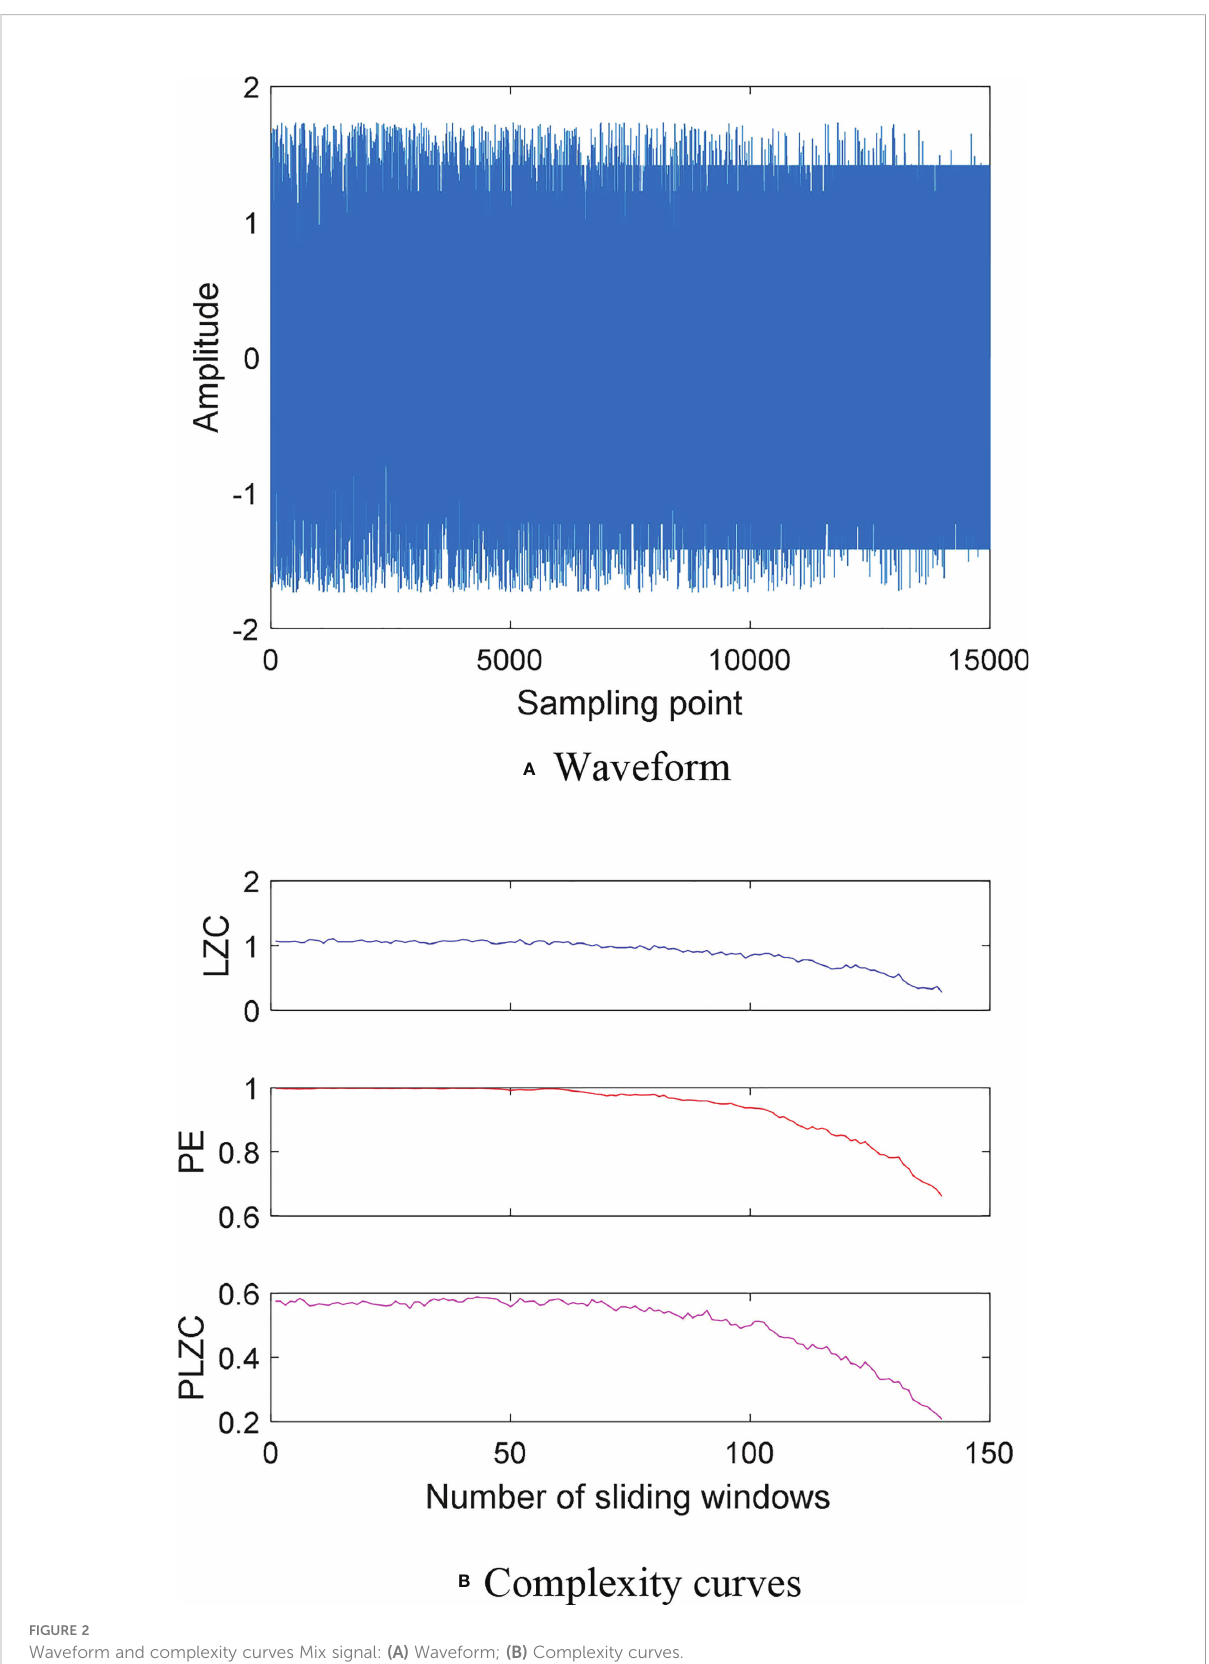
FIGURE 2 Waveform and complexity curves Mix signal: (A) Waveform; (B) Complexity